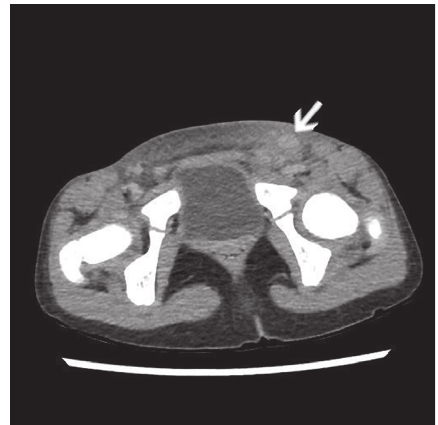
Figure 3: Enhanced computed tomography findings. A pelvic enhanced computed tomography scan showing an enlarged left inguinal lymph node (white arrow, approximately 1.5 × 1.0 cm), densification, and thickening of the regional soft tissue without